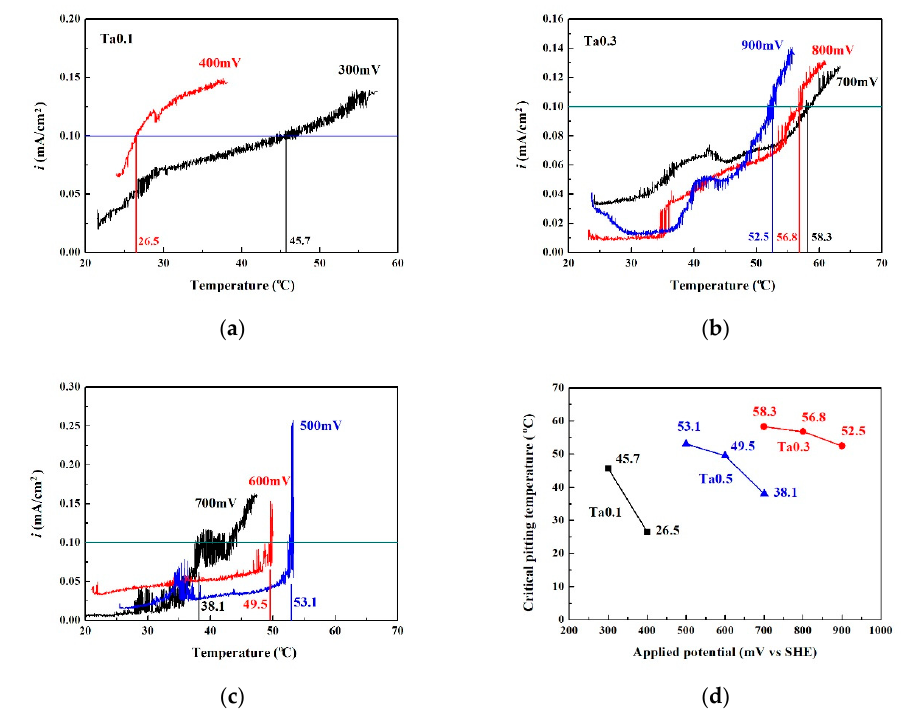
Figure 7. Plots of the CPT test data at different applied potentials (V SHE ). ( a ) Ta 0.1 alloy; ( b ) Ta 0.3 alloy; ( c ) Ta 0.5 alloy. ( d ) shows the relationship between CPT and applied potential for as-cast CoCrFeNiTa x alloys.